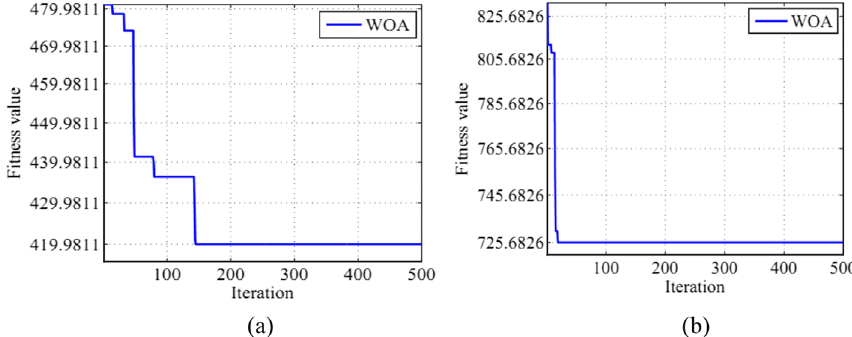
Fig. 14 Convergence characteristic of WOA in the IEEE 14-bus system, increasing of load by: (a) 170%, (b)